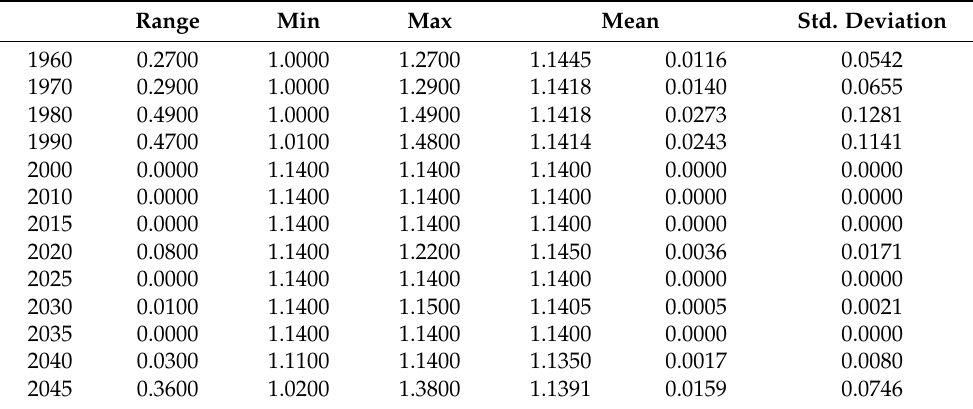
Table 1. Descriptive statistics (male).